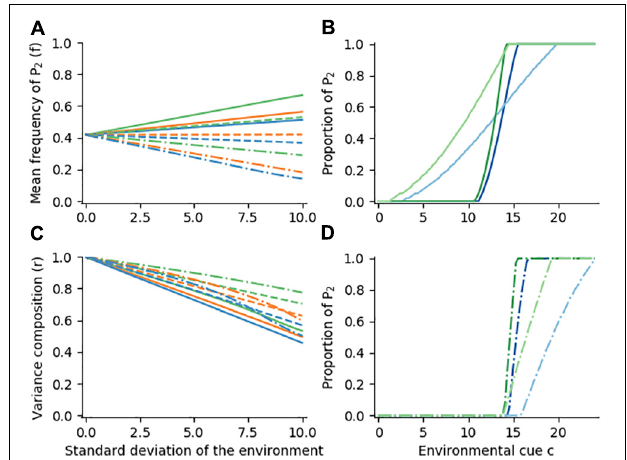
FIGURE 4 | Optimal reaction norm shapes for various growth rate functions and different levels of environmental predictability. Environments are normally distributed around a cue c with a mean of 14. Mean frequency f of phenotype P 2 (Panel A ) and variance composition r (Panel C ) are plotted against standard deviation of the environment. Growth rates of P 2 (diapause) are always 1 for both environments (summer and winter); growth rates of P 1 (parthenogenesis) in E 1 / E 2 are 4/0.1 (blue, solid), 3/0.1 (orange, solid), 2/0.1 (green, solid); 4/0.33, 3/0.33, 2/0.33 (dashed blue, orange and green lines); and 4/0.66, 3/0.66, 2/0.66 (dash-dotted blue, orange and green lines). Panels (B–D) show optimal reaction norms for environments with standard deviations of 2 (darker shade) and 8 (lighter shade) in the according line styles and